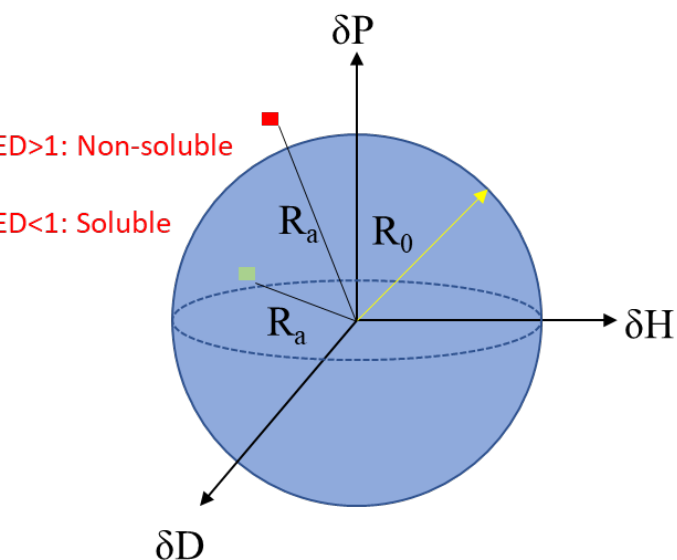
Figure 1. Hansen solubility parameter (HSP) sphere: Red square represents a solvent with a relative energy difference (RED) value > 1 (i.e., theoretically non-soluble solvents); and the green square represents a solvent with a RED value < 1 (i.e., theoretically soluble solvents).